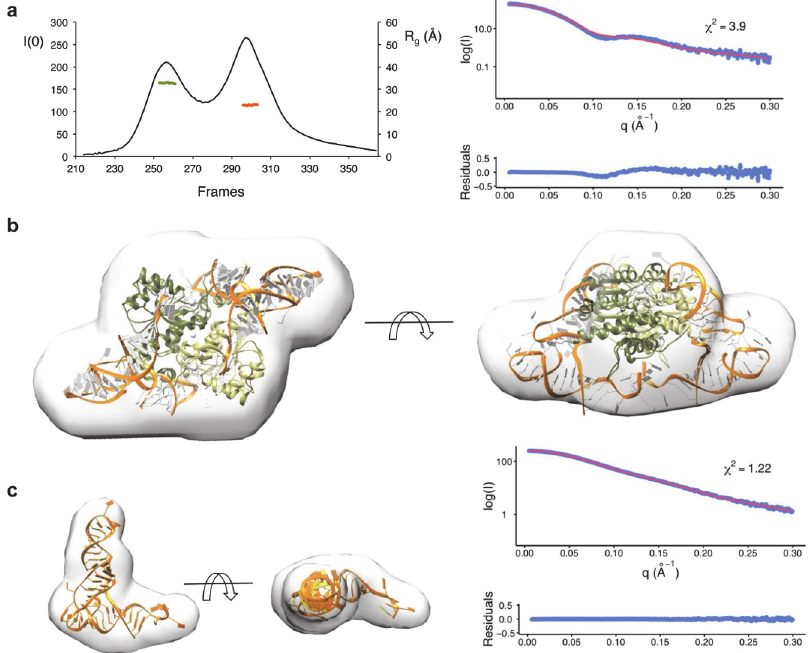
Fig 8. Solution structure of TcdA-tRNA Lys (UUU). a SAXS data for TcdA-tRNA Lys was measured using an online HPLC setup to separate complex from excess free tRNA. The graph shows a plot of the SAXS intensity at zero angle, I(0) (left axis, curve represented as a solid black line), and of the radius of gyration, R g (on the right axis), versus data-collection frames. Frames 253 – 263 (green line) were merged and used for shape restoration of the TcdA-tRNA Lys (UUU), and frames 304 – 310 were used for the control reconstruction of the tRNA Lys (UUU) shape. b Best model calculated for the TcdA-tRNA Lys (UUU) complex overlayed by the ab initio SAXS shape calculated with DAMMIF. The crystal structure of TcdA-ATP is represented in green cartoon and the tRNA is depicted with its main chain as a gold ribbon and the bases as ladders. The fit (red line) to the experimental SAXS data (blue points), calculated with CRYSOL, χ 2 and residuals are shown. c Like in ( b ), for free tRNA Lys (UUU). In this case, the model is a rigid-body fit of the tRNA structure into the ab initio SAXS